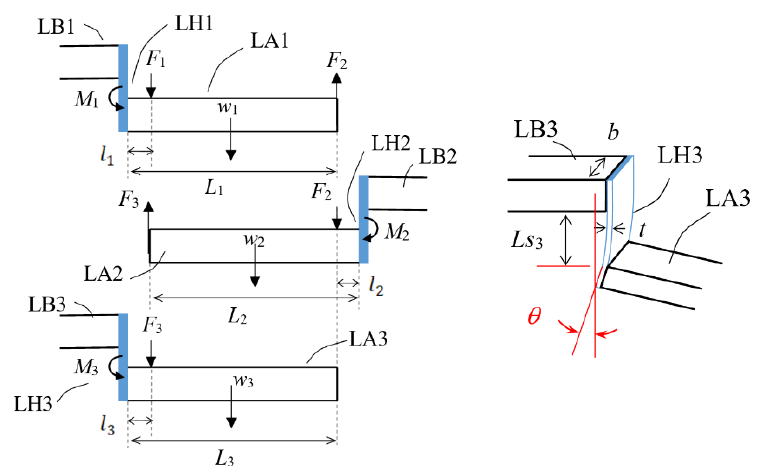
Figure 12. A simplified analytical model of the cascaded lever structures.